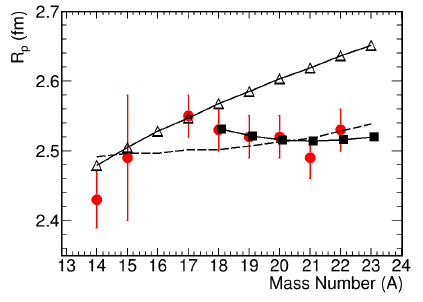
Figure 1. The experimental point-proton radii are shown with red filled circles. Shell model predictions using the YSOX in- teraction and WS (HO) potentials are shown with black filled squares (black open triangles). RMF theory predictions are given with the black dashed curve from Ref.